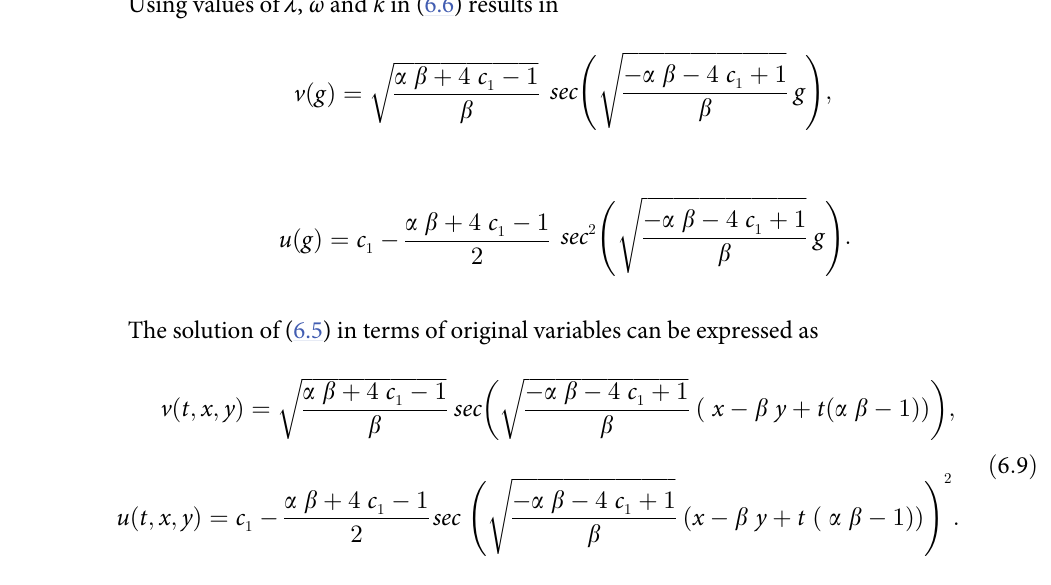
ffiffiffiffiffiffiffiffiffiffiffiffiffiffiffiffiffiffiffiffiffiffiffiffiffiffiffiffi a b þ 4 c